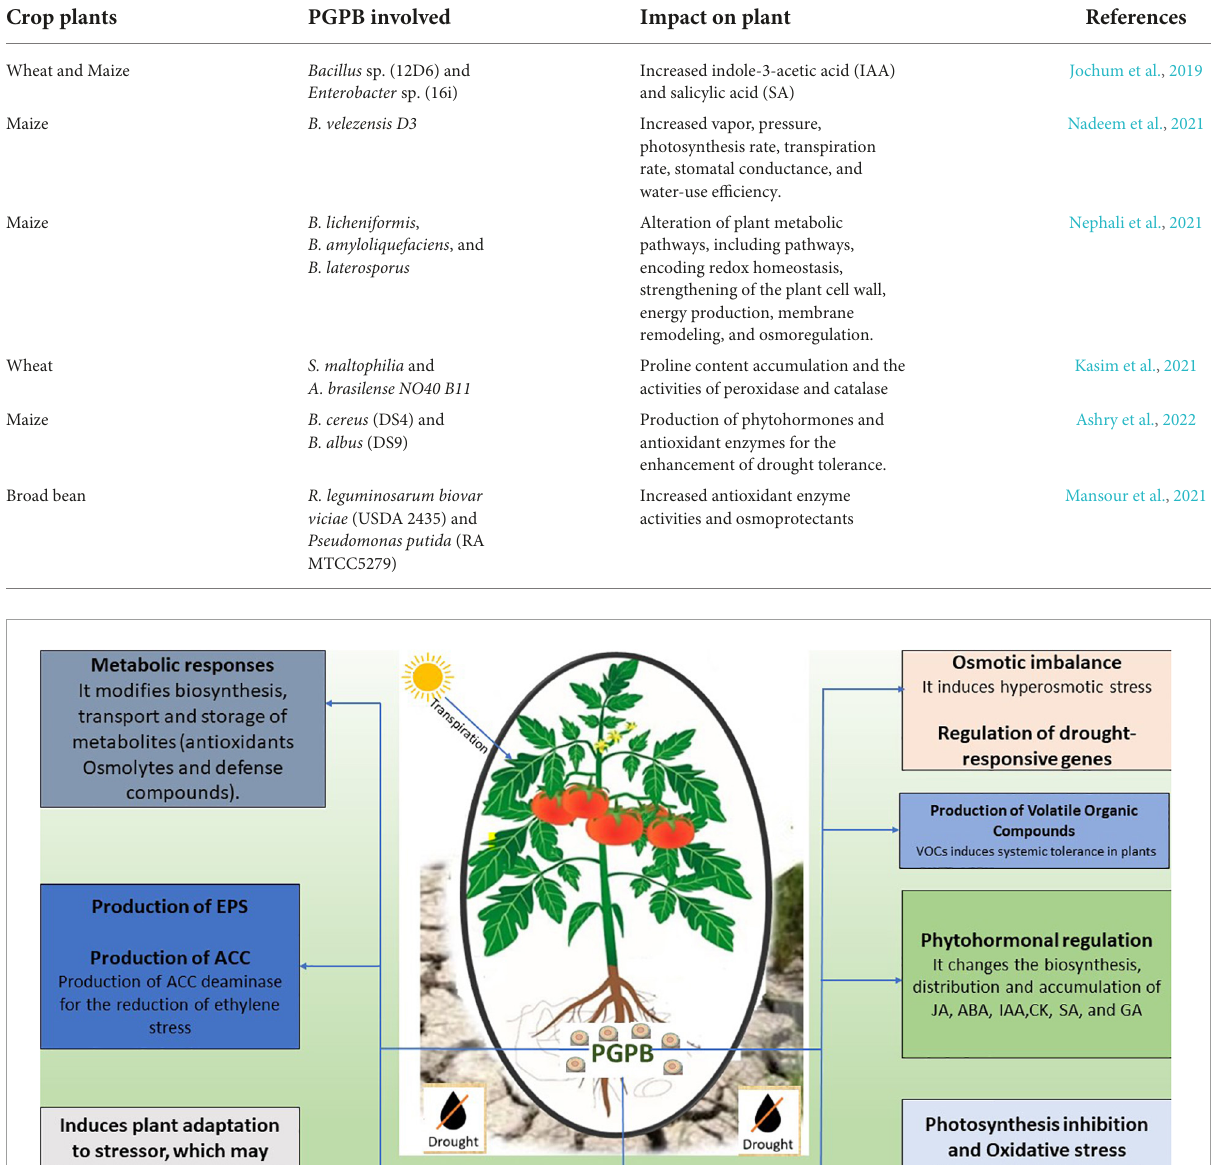
The host plants coated with bacteria, often possess a stronger root system with more lateral roots, and an increment in main root length helps the plant in enhancing plant drought stress better than control plants (Zhou et al., 2016). As a result, plants with higher levels of amino acid and soluble sugars are thought to be better able to withstand drought. Under drought